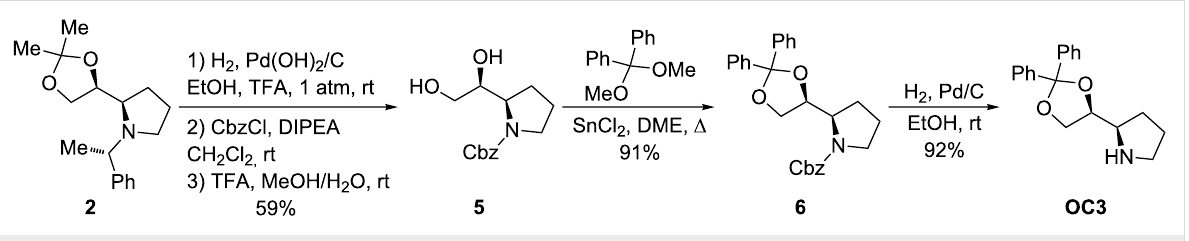
Scheme 3: Synthesis of new organocatalyst OC3 .